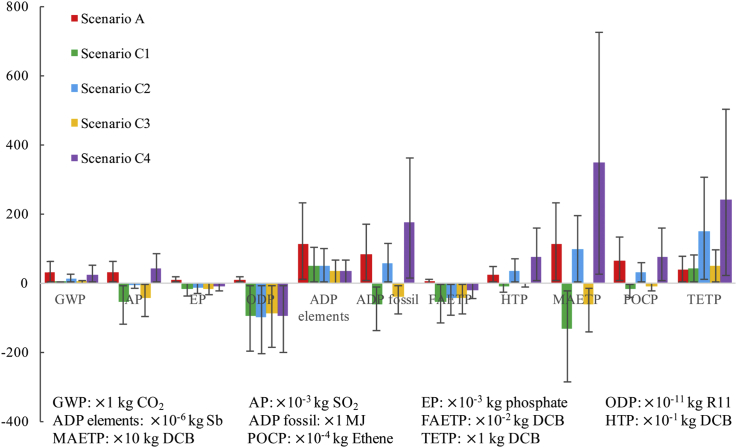
Comparative environmental profiles for SC1, SC2, SC3 and SC4.